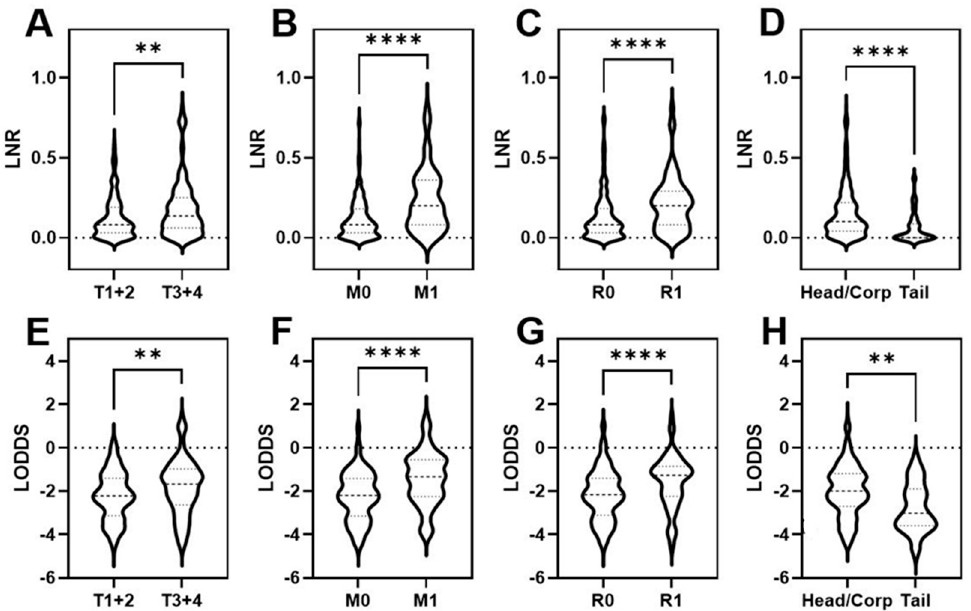
Figure 1. Violin plots depicting the association of LNR and LODDS with T category ( A , E ), presence of distant metastasis ( B , F ), resection margins ( C , G ), and tumor localization ( D , H ). ** p < 0.01; **** p < 0.0001.